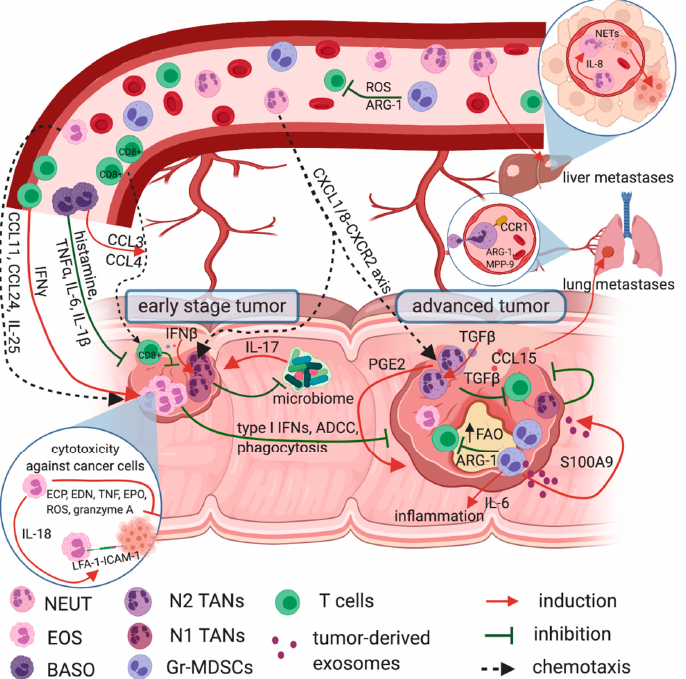
Figure 2. Granulocytes role in CRC. Eosinophils have an anti-tumor role in CRC and their infiltration into the tumor is considered as a positive prognostic marker. They are recruited to the tumor site by CCL11, CCL24, and IL-25 where they are activated by IFN γ to secrete ECP, EDN, EPO, TNF, granzyme A, and produce ROS, all with direct cytotoxicity against cancer cells. Tumoricidal effect of eosinophils depends on cell-to-cell contact and IL-18, which in the autocrine loop enhances the LFA-1—ICAM-1 mediated eosinophil adhesion to the target cells. Basophils are also beneficial in CRC and their role is related to the secretion of the granules content, including histamine and proinflammatory cytokines—e.g., TNF α , Il-6, IL-1 β —augmenting inflammatory reaction, recruiting cancer-specific CD8+ T cells (CCL3 and CCL4) into the tumor and enhancing cancer cell apoptosis. Neutrophils possess both anti-tumor and pro-tumorigenic activities. Under the influence of CXCL8 (IL-8) they are recruited from peripheral blood to the tumor site and prompted for NETs formation, which support tumor spread and liver metastasis. Additionally, neutrophils are recruited into the tumor by CCL15-CCR1 pathway, where CCR1+ TANs with ARG-1 and MMP-9 activity are associated with lung metastasis. In tumors, TANs are involved in local immunosuppression through prostaglandin PGE2 and TGF β secretion, supporting the tumor growth. Unlike N2, N1 TANs possess anti-tumorigenic functions. Their increased infiltration was shown in the early stage of CRC, where they affect the colon microbiome and hamper IL-17 dependent tumor development. Moreover, activated by type I IFNs N1 TANs inhibit angiogenesis and effectively eliminate tumor cells via antibody dependent cell-mediated cytotoxicity (ADCC) or phagocytosis. Gr-MDSCs are potent inhibitors of T cell proliferation and anti-tumor response. Their mechanisms involve ARG-1 activity, ROS production, an increased fatty acid uptake and activated fatty acid oxidation (FAO). Moreover, Gr-MDSCs produce high amounts of IL-6 for sustained inflammation in colon epithelium, thereby promoting CRC progression. Pro-tumorigenic action of Gr-MDSCs also includes secretion of exosomes containing S100A9, which additionally stimulate the tumor growth.